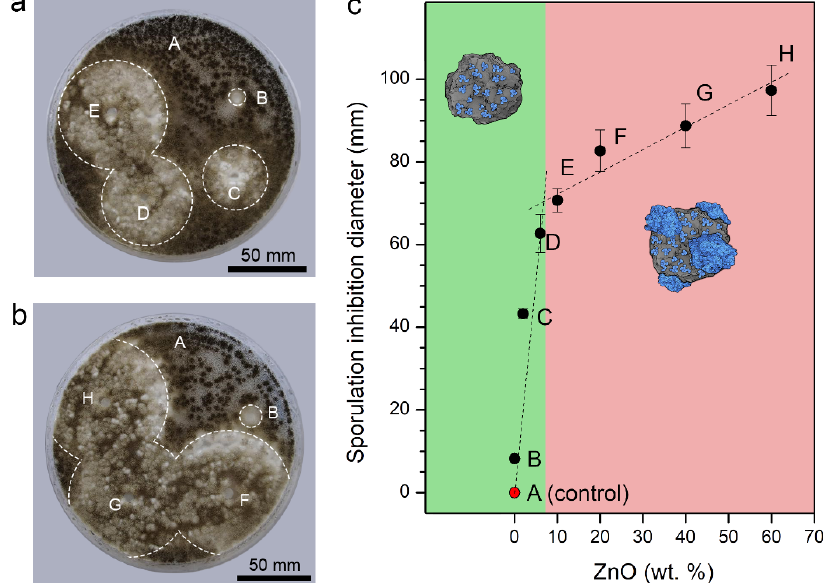
Figure 3. Antifungal activity test of ZnO/Clay composites against Aspergillus niger . Panels ( a ) and ( b ) show photographs of Bauer-Kirby disk diffusion assay for different composition of ZnO (wt.%) content in clay: (A) Control, (B) clay, (C) 2%, (D) 6%, (E) 10%, (F) 20%, (G) 40%, (H) 60%. Panel ( c ) shows sporulation inhibition diameter data mean values and standard errors of a 0.5 wt.% concentration of ZnO/Clay. The effectiveness zone is represented in green and one of less effectiveness is colored in red. Each data represents an average of triplicate measurements.